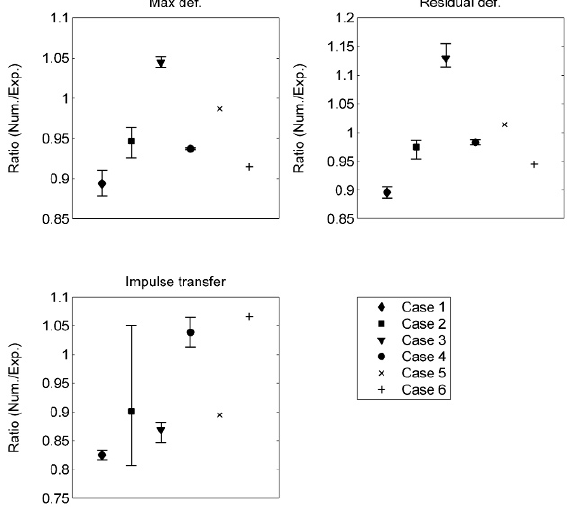
Figure 15. Numerical results for Case 1–6 relative to the experi- mental results regarding max plate deformation, residual plate deformation and impulse. Case 1–4 are given with confidence bounds from the experiments.